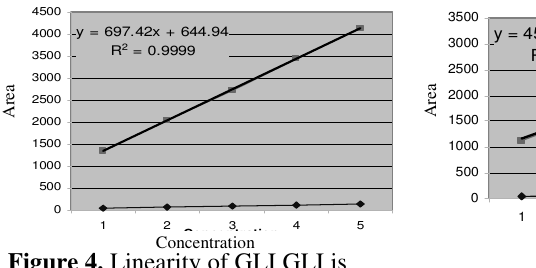
Figure 5. Linearity of ROSE